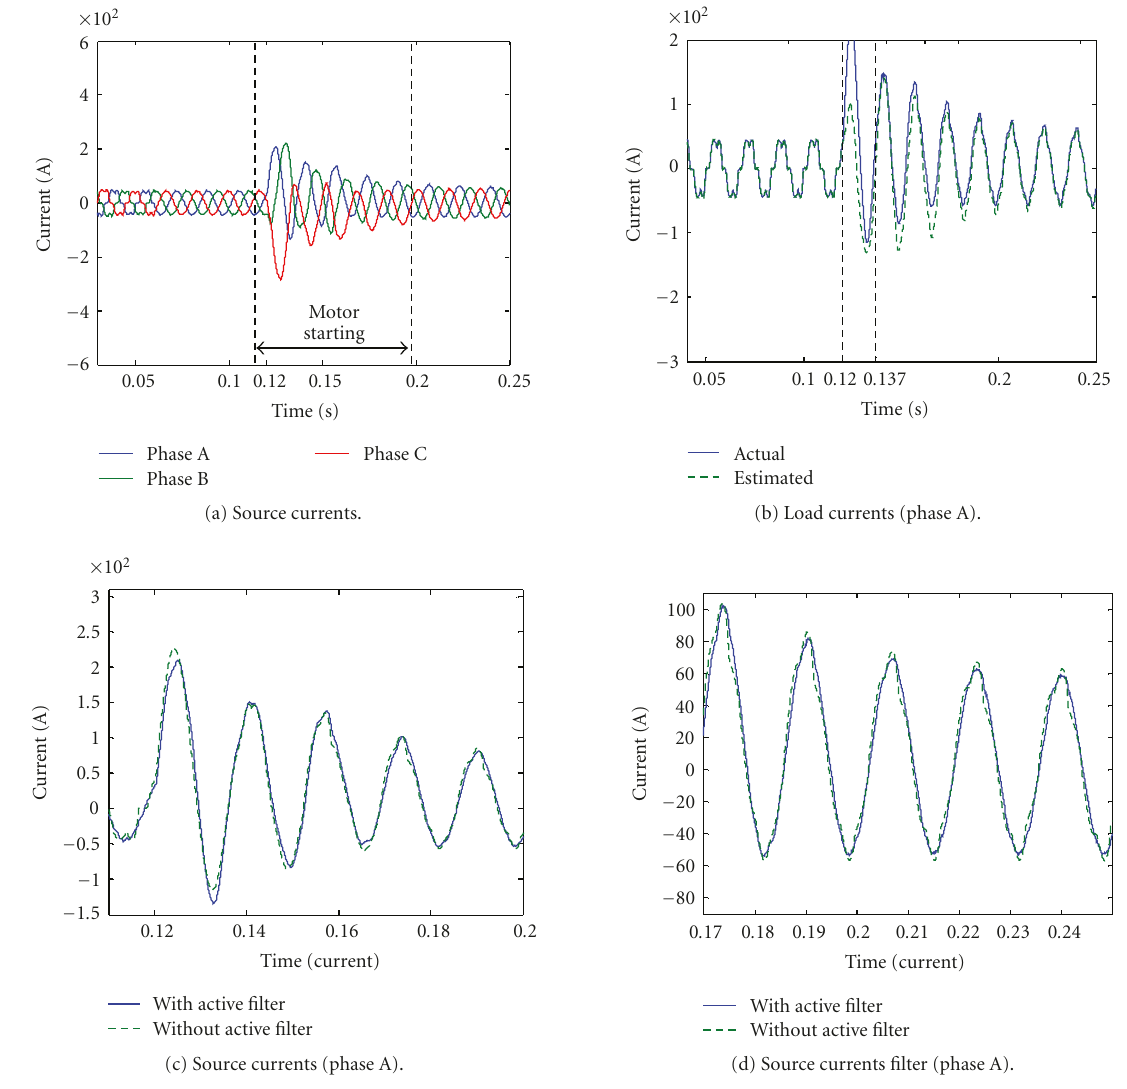
Figure 6: Simulation results of case 2